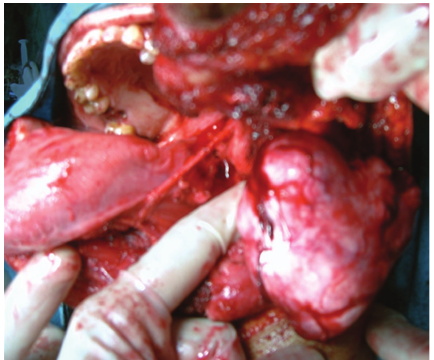
Figure 4: Tumor being delivered by “paramedian mandibulotomy with mandibular swing”